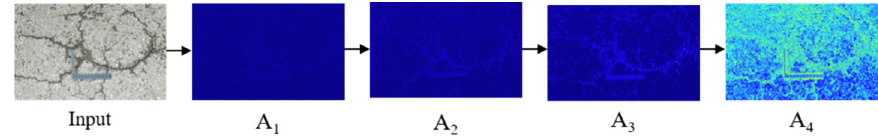
Figure 4. Attention map at different stages.